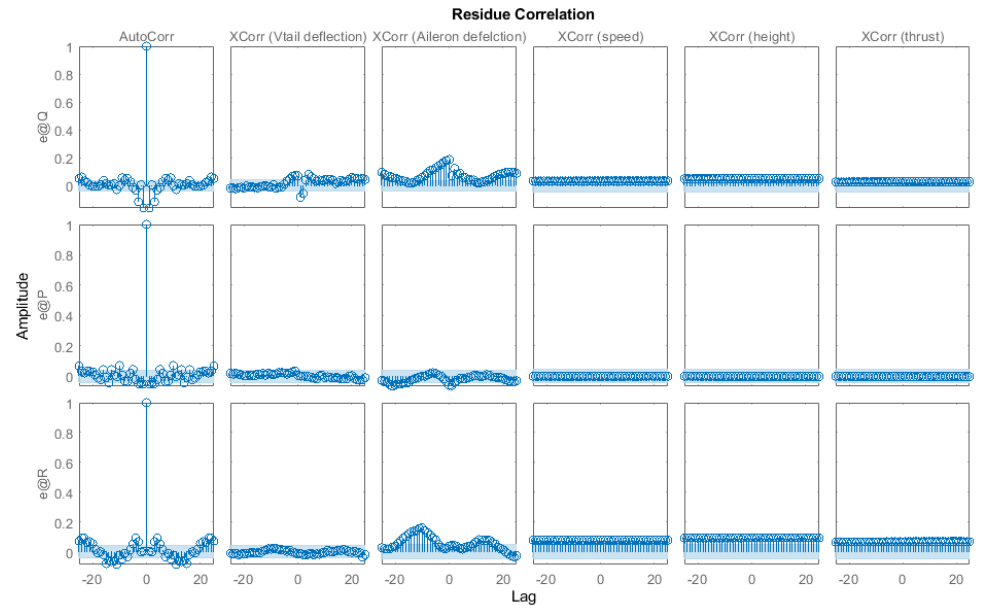
Figure 15. BJ Model Residue Correlation.